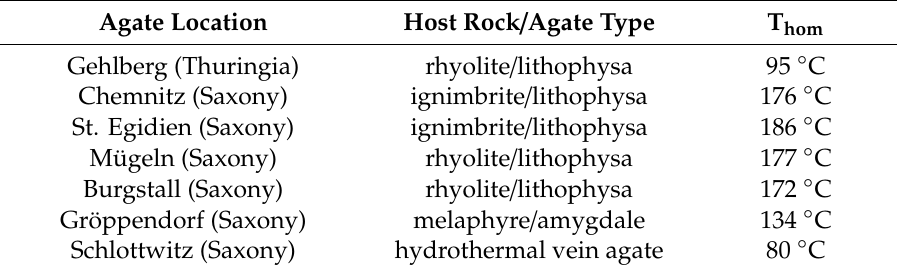
Table 3. Minimum homogenization temperatures (T hom ) obtained from fluid inclusion studies of agates from di ff erent occurrences in